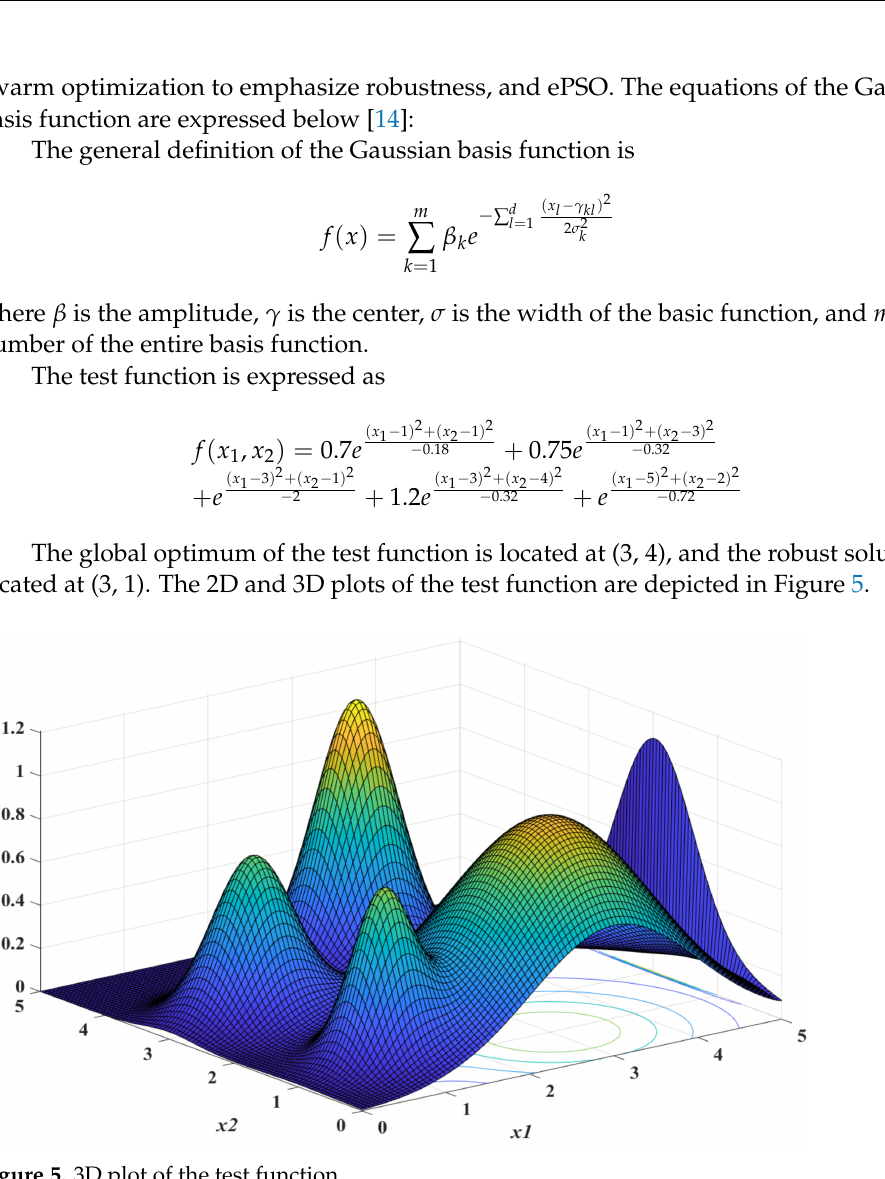
Figure 5. 3D plot of the test function.